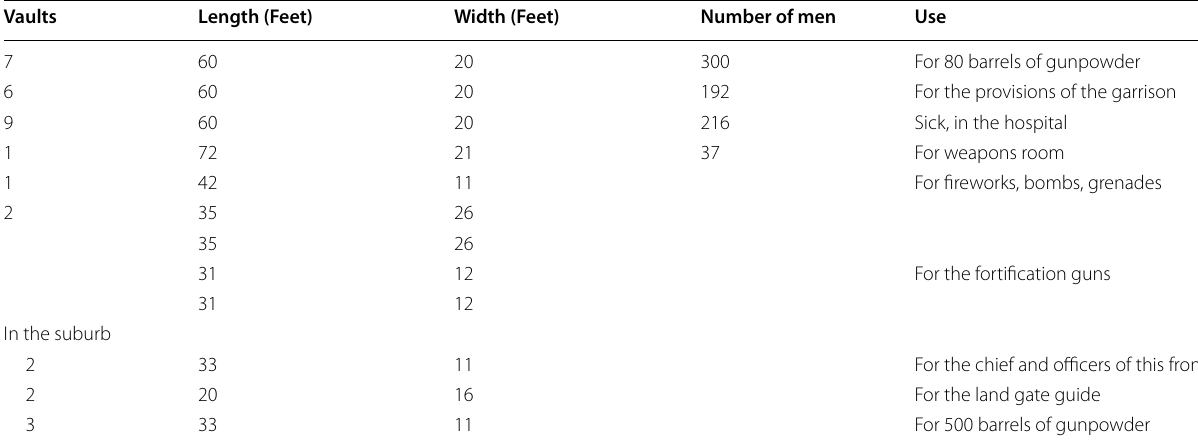
Table 2 Number of men and ammunition (Anguiano